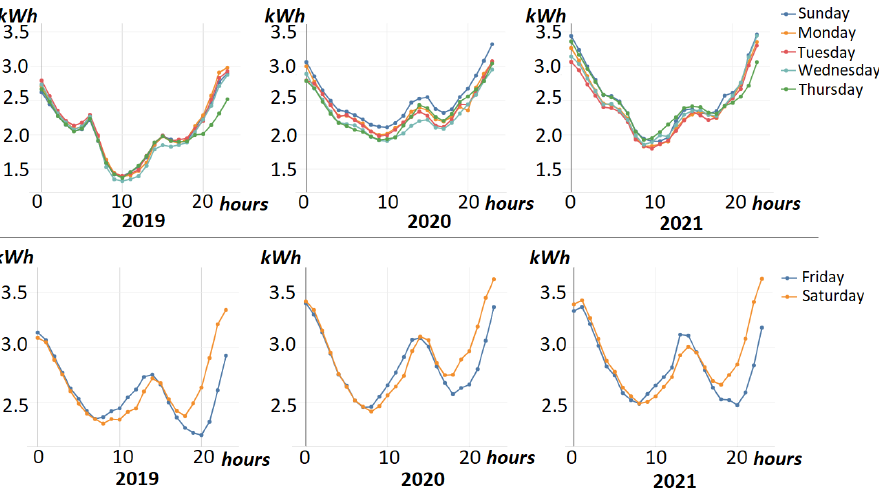
Figure 14. Mean hourly consumption profile for weekdays ( top ) and weekends ( bottom ) for 3 months over 3